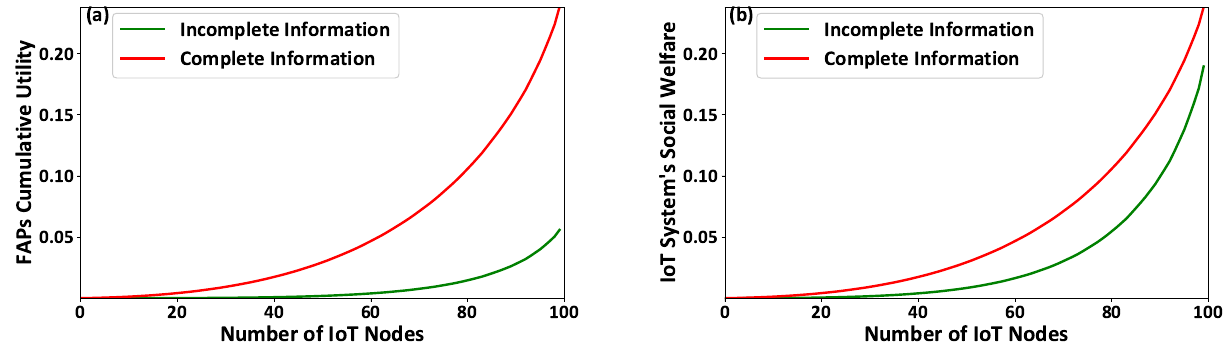
Figure 3. ( a ) FAPs’ cumulative utility and ( b ) the overall IoT system’s social welfare under the proposed contract-theoretic energy harvesting framework—Complete versus Incomplete information